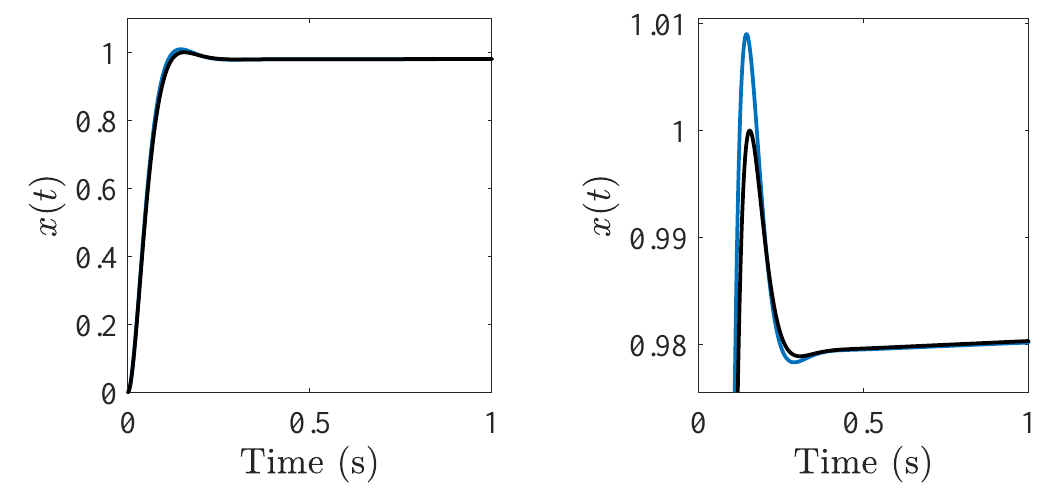
Figure 7. Response of an optimal solution x pq (black) and light robust solution x lr (blue) with respect to time in